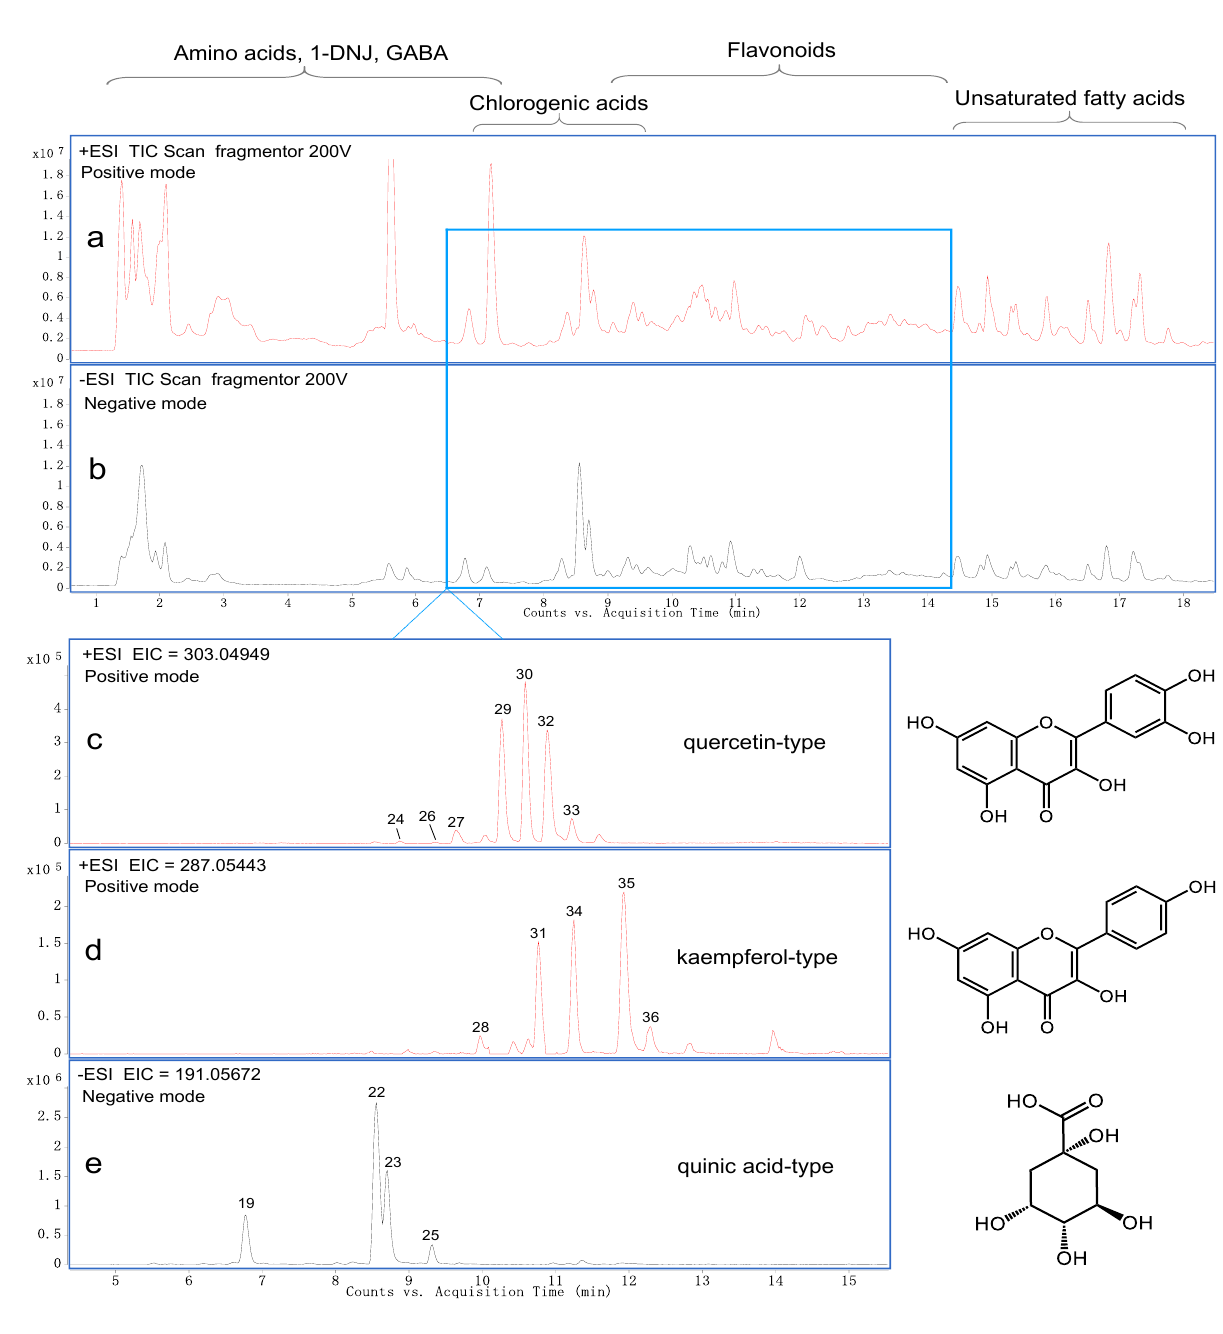
Figure 2. TICs of Morus spp. leaves (QC) in − ESI ( a ) an d +ESI ( b ) modes, EIC finding potential skeletons of quercetin, kaempferol, and quinic acid at m / z 303.05 ( c ), m / z 287.05 ( d ), and m / z 191.05 ( e ), respectively.